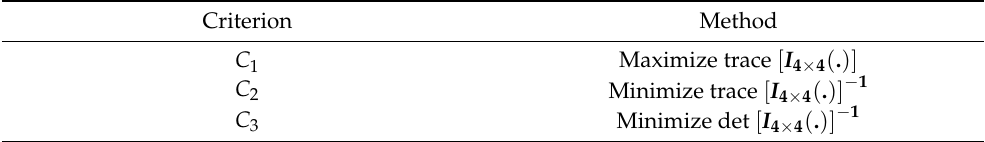
Table 1. Some practical censoring plan optimum